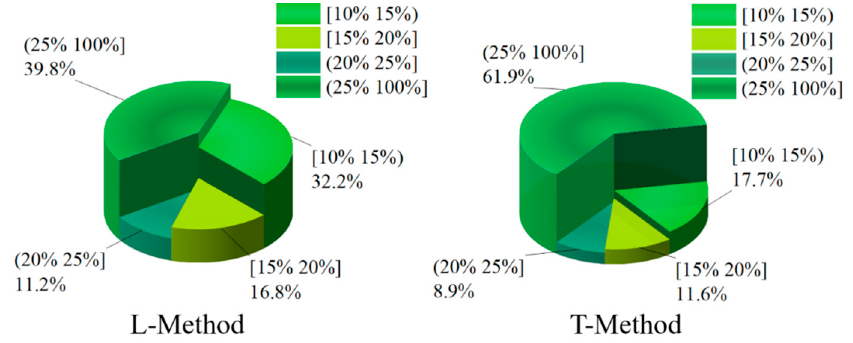
Figure 17. Ratio of right-rear wheel slip under different control strategies.